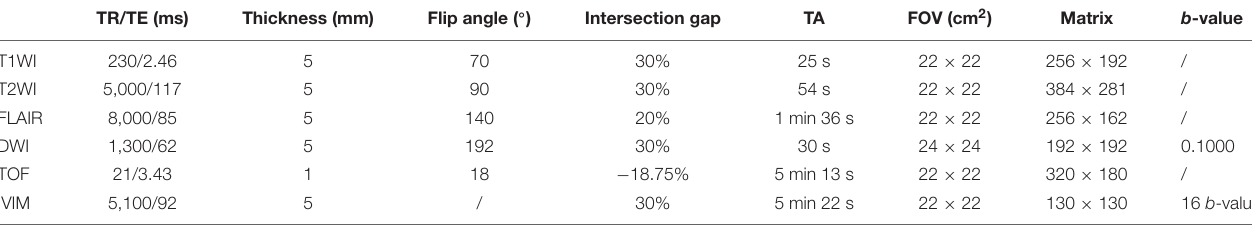
TABLE 1 | MRI scanning sequences and